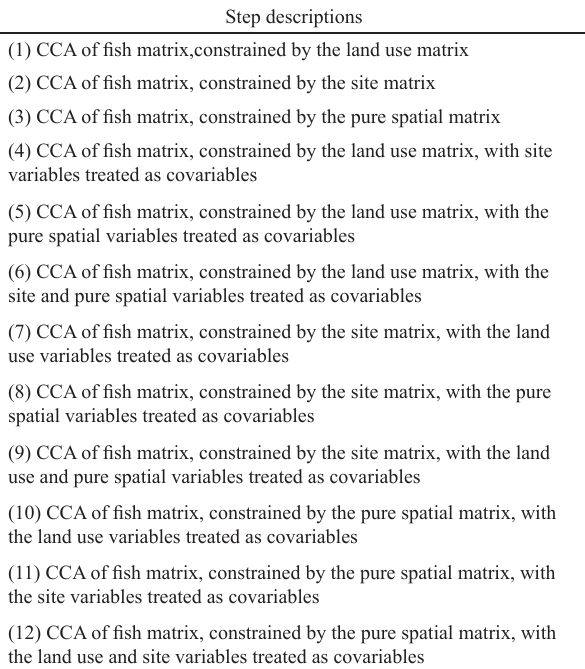
Table 2. Step descriptions of the 12 CCAs run over fish abundance and incidence